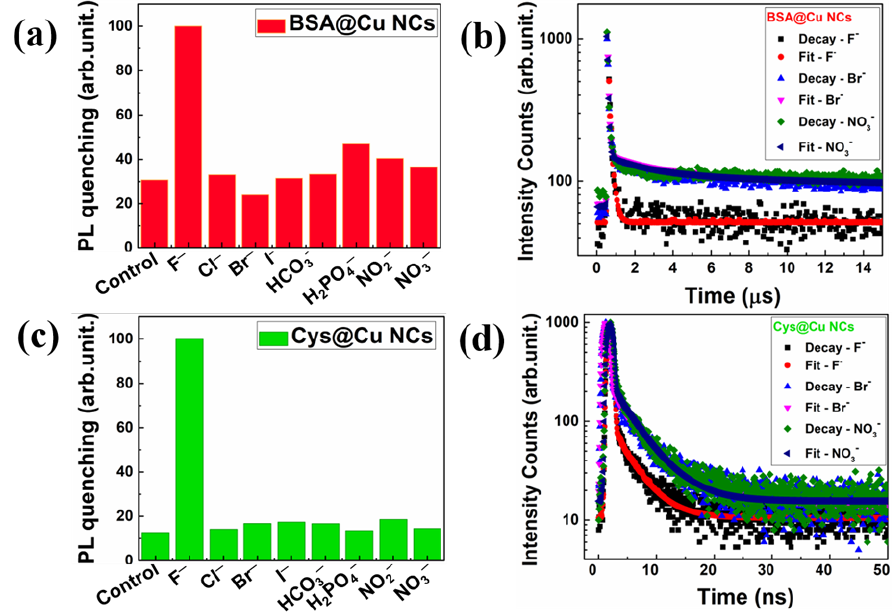
Figure 5. The change in the fluorescence intensity and the radiative decay patterns were measured with two different color-emitting Cu NCs in the presence of various anions at 0.1 M concentrations. ( a , b ) BSA-Cu NCs and ( c , d ) Cys-Cu NCs.